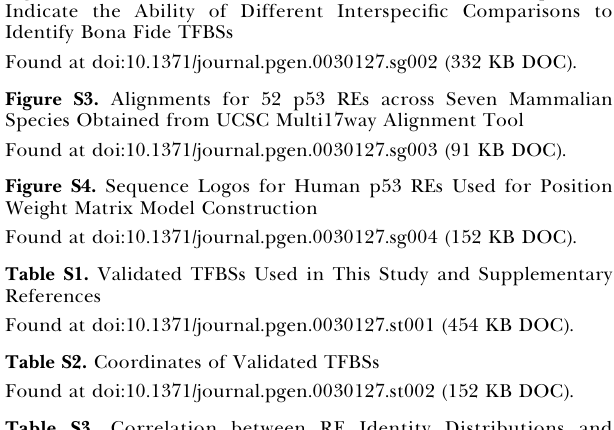
Figure S1. Distribution of Human-to-Primate TFBS Conservation Scores Found at doi:10.1371/journal.pgen.0030127.sg001 (295 KB DOC). Figure S2. ROC Curves for Four Human-to-Mammal Comparisons Indicate the Ability of Different Interspecific Comparisons to Identify Bona Fide TFBSs Found at doi:10.1371/journal.pgen.0030127.sg002 (332 KB DOC). Figure S3. Alignments for 52 p53 REs across Seven Mammalian Species Obtained from UCSC Multi17way Alignment Tool Found at doi:10.1371/journal.pgen.0030127.sg003 (91 KB DOC). Figure S4. Sequence Logos for Human p53 REs Used for Position Weight Matrix Model Construction Table S1. Validated TFBSs Used in This Study and Supplementary References Table S2. Coordinates of Validated TFBSs Table S3. Correlation between RE Identity Distributions and Distributions Obtained from Sampling of Promoter Fragments Found at doi:10.1371/journal.pgen.0030127.st003 (39 KB